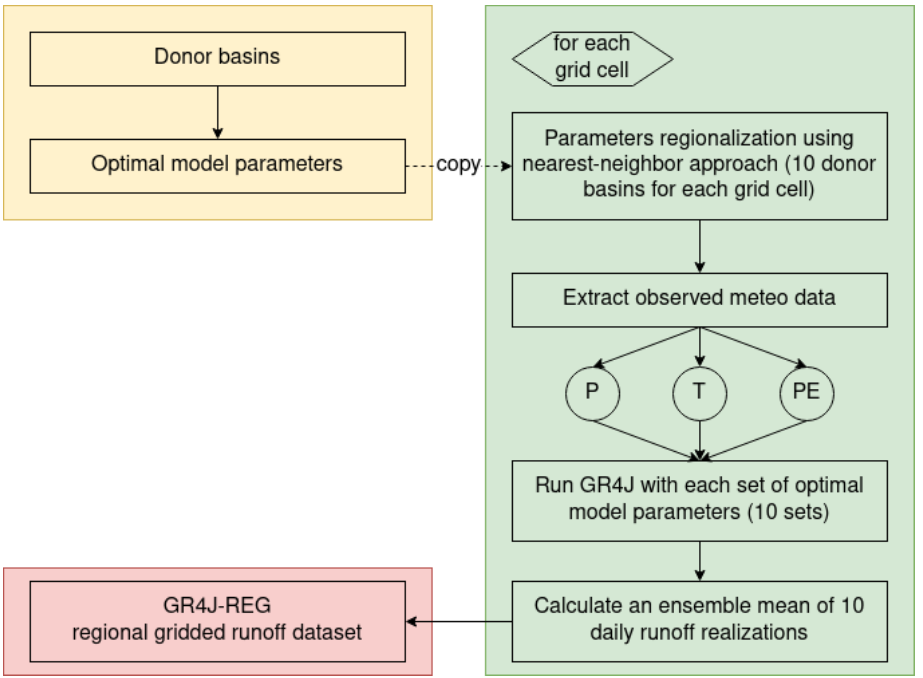
Figure 4. Schematic representation of the proposed workflow for the development of the GR4J- REG dataset.